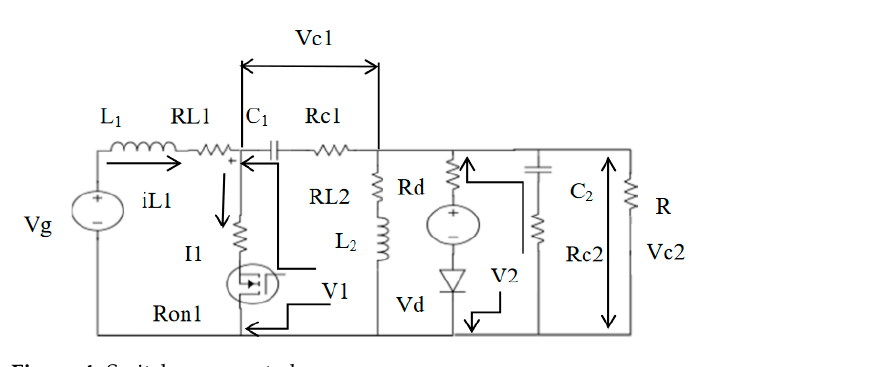
Figure 4. Switches separated.